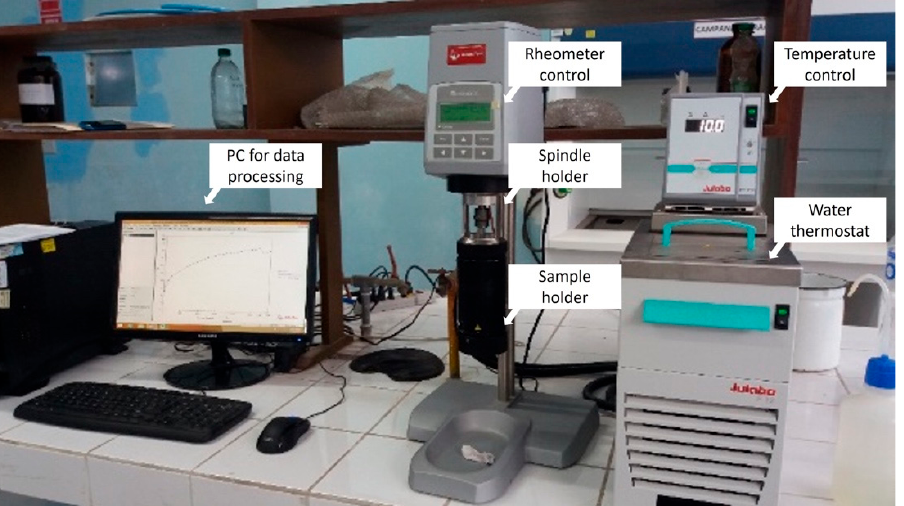
Figure 1. Measuring system—Rheolab QC rotational rheometer. Research laboratory of the Faculty of Chemical Engineering. The National University of Callao. Callao. Peru.